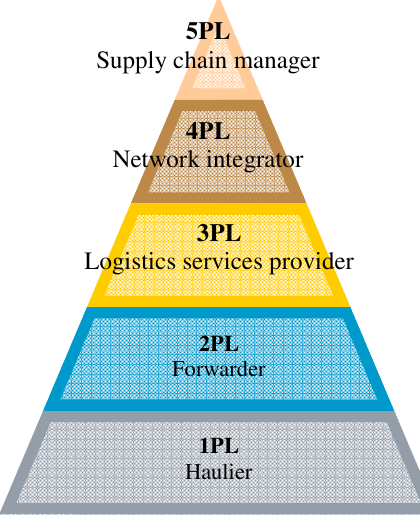
Fig 1. From 1PL to